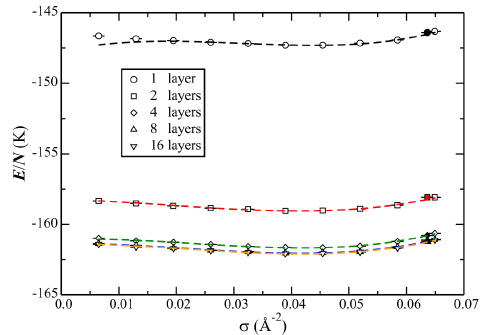
Figure 10. Phase diagram of 4 He adsorbed on graphite. Note that these results were calculated using the atom–bond He–C